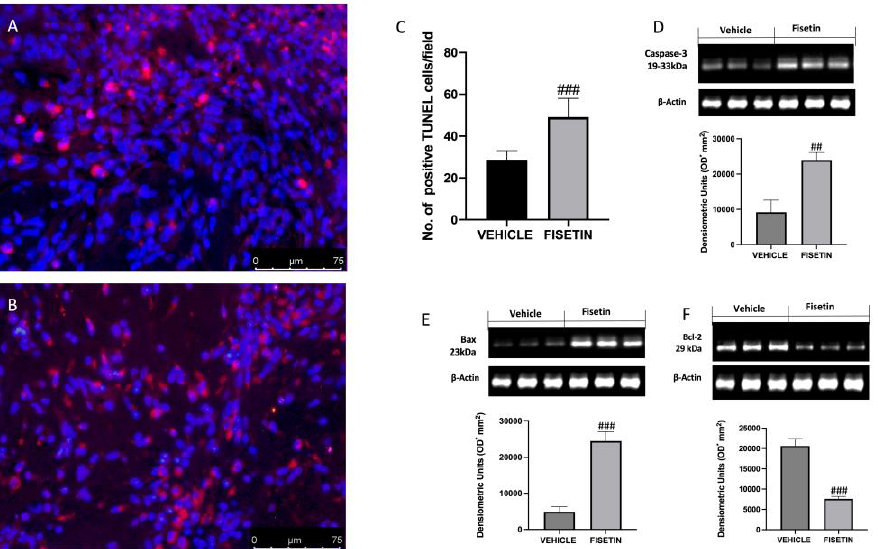
Figure 7. Fisetin administration on apoptosis: TUNEL staining to see positive apoptotic cells was performed in ( A , B ), endometriosis + vehicle ( A ) + fisetin ( B ). The number of apoptotic cells per field of endometriotic lesions ( C ). Figures are from at least three divided experiments. Western blots for caspase 3, Bax, and Bcl-2 ( D – F ). Exposed is a blot of lysates (6 animals/group) with a densitometric analysis for all animals. The results are means ± SEM of 6 animals for each group. ### p < 0.001 vs. vehicle, ## p < 0.01 vs. vehicle. Scale bar 75 µ